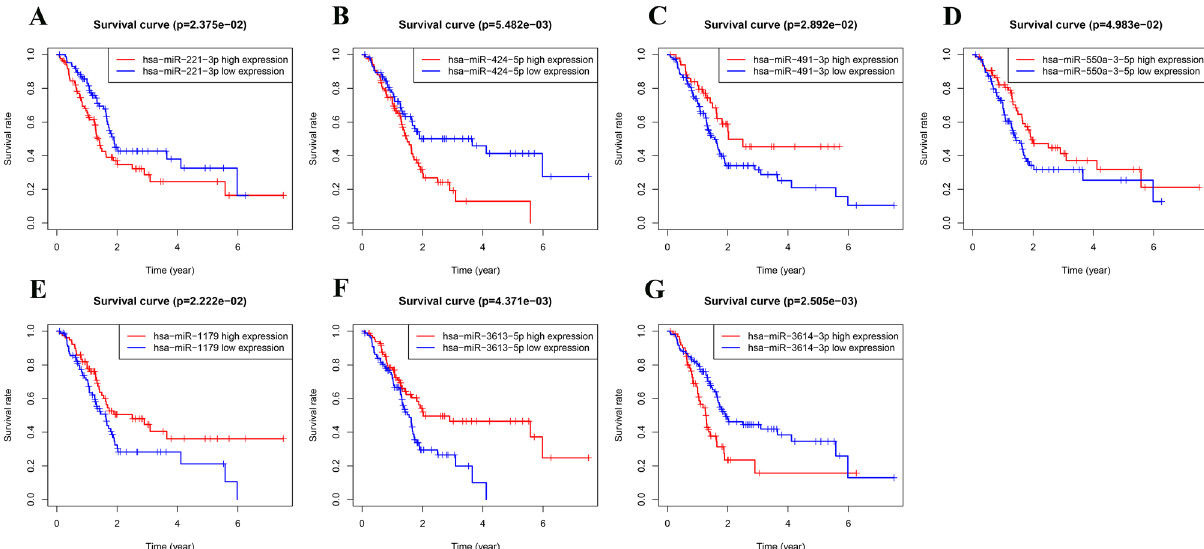
Figure 3. Kaplan–Meier survival curve of 7-immune-related prognostic miRNA. According to the median expression of miRNAs, patients were divided into high-expression groups and low-expression groups. ( A ) KM analysis for patients with hsa-miR-221-3p; ( B ) KM analysi for patients with hsa-miR-424-5p; ( C ) KM analysis for patients with hsa-miR-491-3p; ( D ) KM analysis for patients with hsa-miR-550a-3-5p; ( E ) KM analysis for patients with hsa-miR-1179; ( F ) KM analysis for patients with hsa-miR-3613-5p; ( G ) KM analysis for patients with